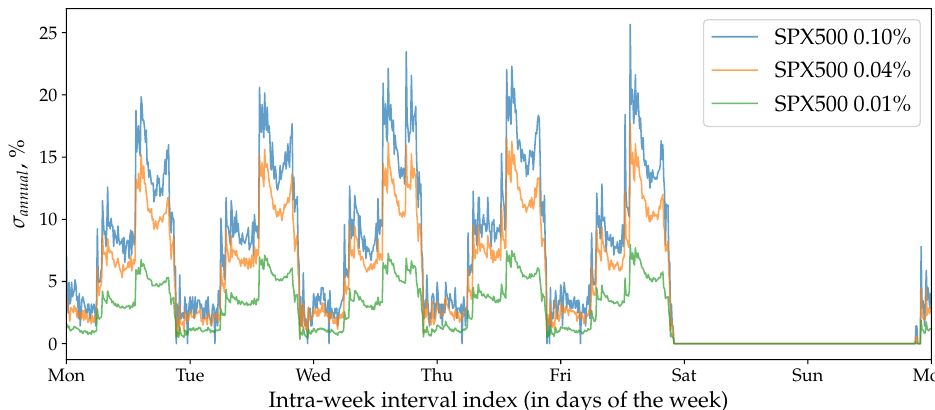
Figure 11. Volatility seasonality of SPX500 computed using the novel approach (Equation (19)) and three different thresholds: δ = a week.